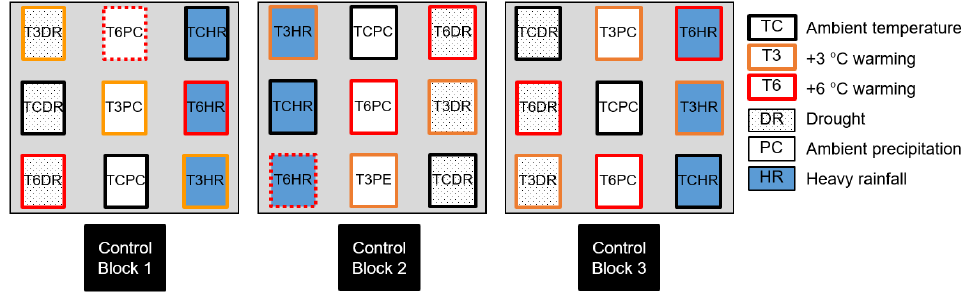
Figure 2. Open-field experimental design of extreme climate events regarding temperature and precipitation using L. kaempferi seedlings.